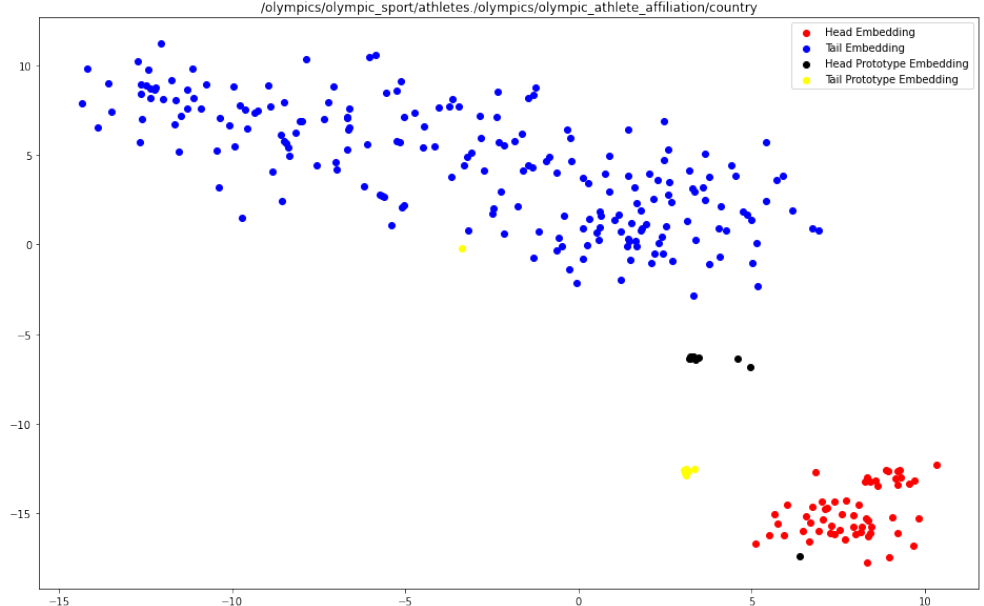
Figure A1. A total of 57 different head entities, 209 different tail entities, and 154 records in the training data.